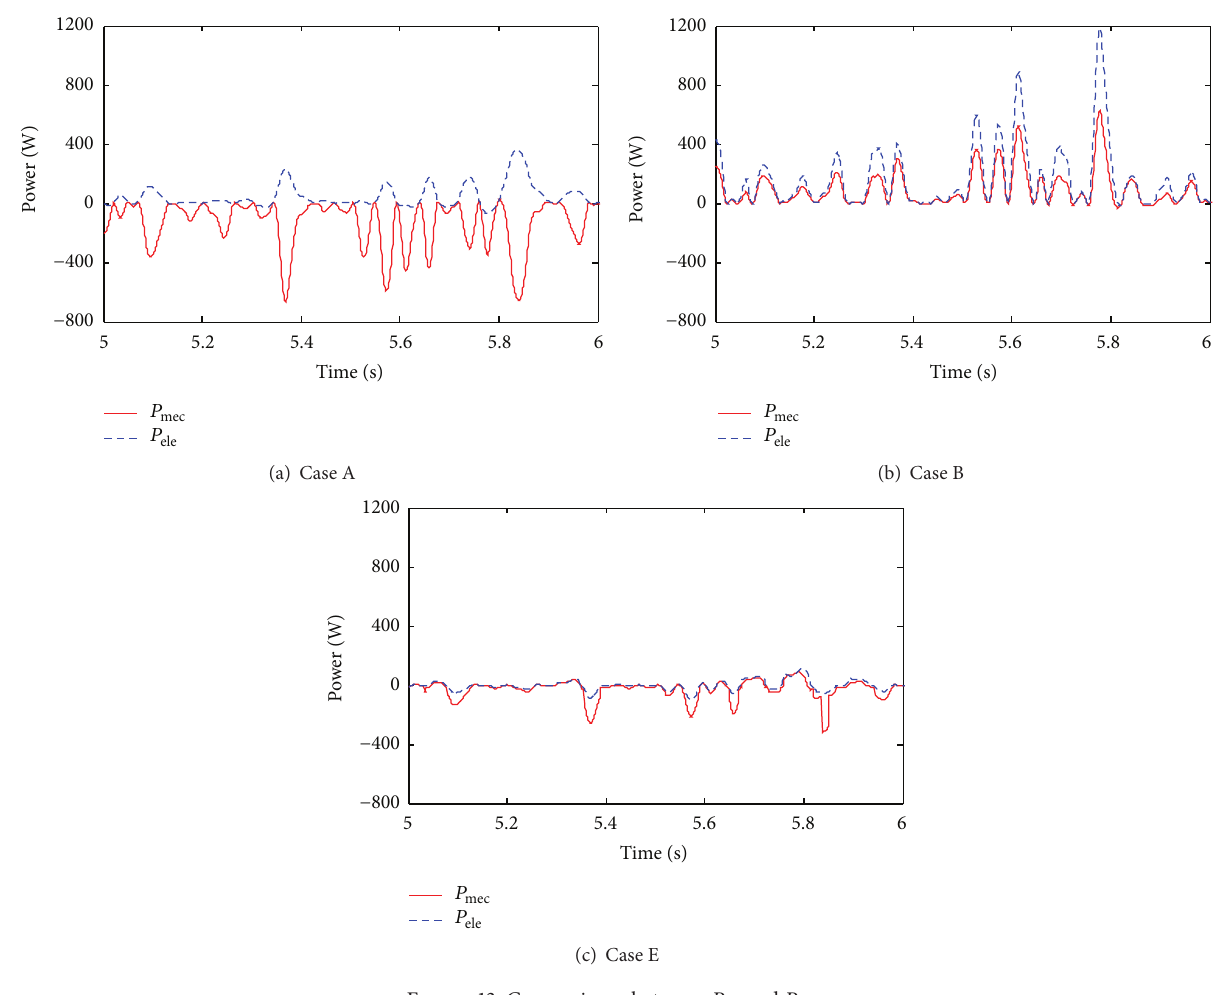
Figure 13: Comparisons between 𝑃 ele and 𝑃 mec .